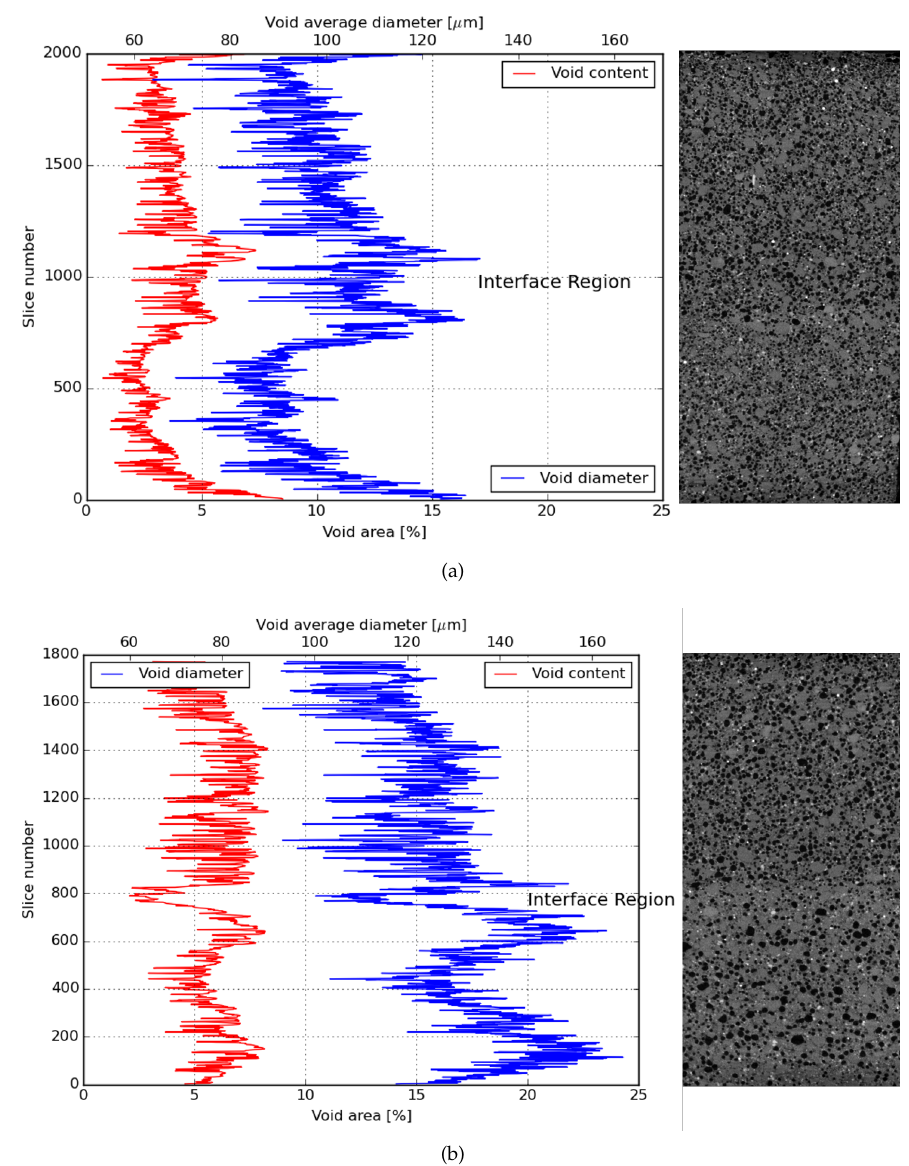
Figure 16. Average air void content and diameter distribution in the height of a 2-layer printed element of Y series. ( a ) Y2T; ( b )